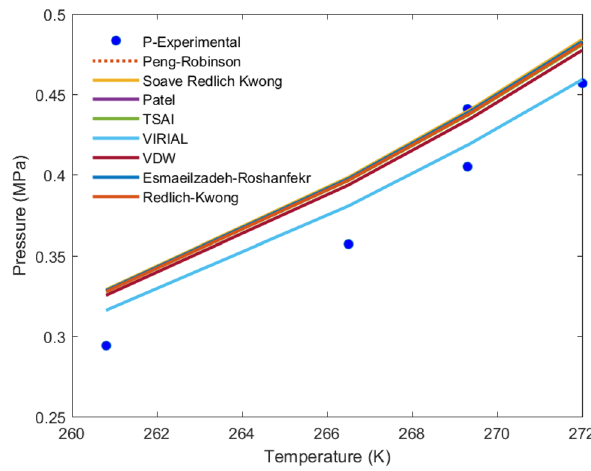
Fig. 3 Predicted pressure versus experimental plot for I – H – V phase region, AAD %, [Min/Max] of [1.5/5.4]